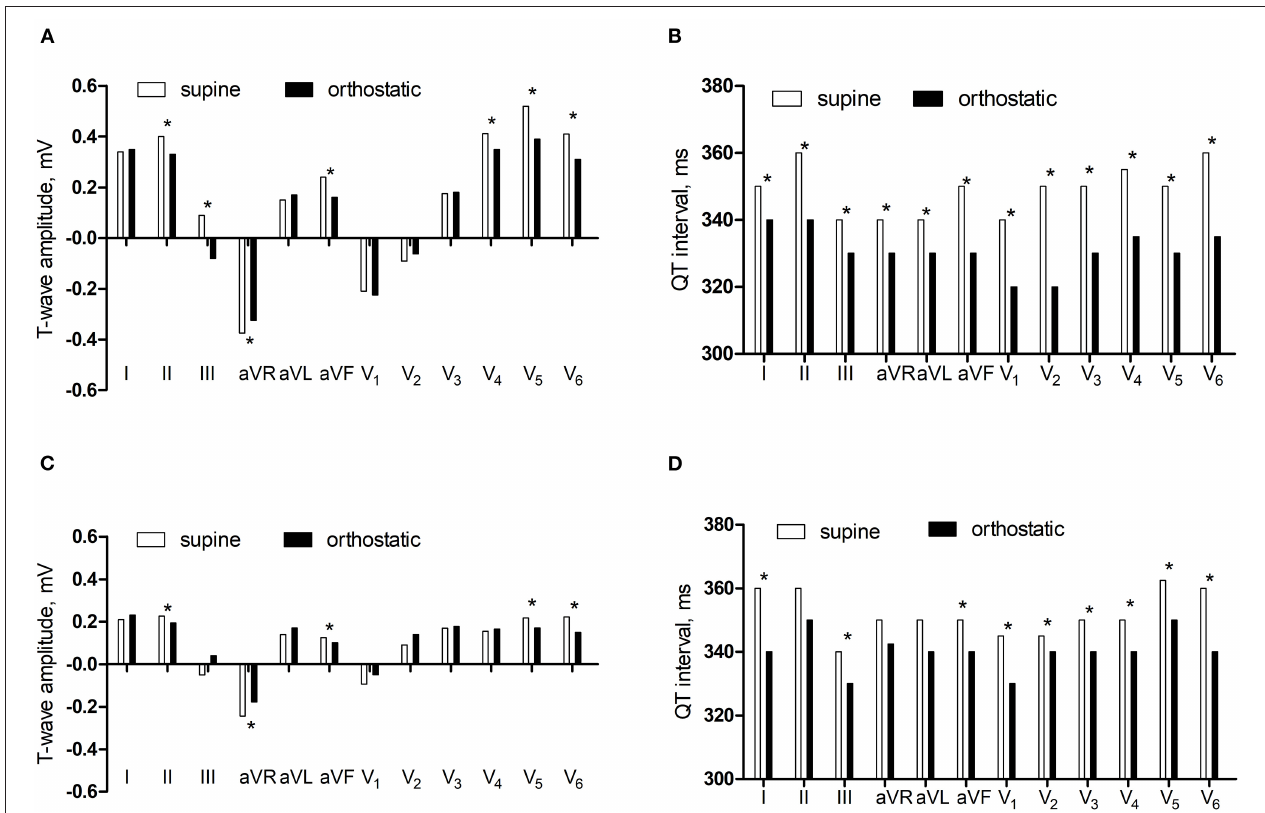
FIGURE 1 | The comparisons of T-wave amplitude and QT interval between supine and orthostatic ECG. (A) The T-wave amplitude in the control group. (B) The QT interval in the control group. (C) The T-wave amplitude in the research group. (D) The QT interval in the research group. * P <